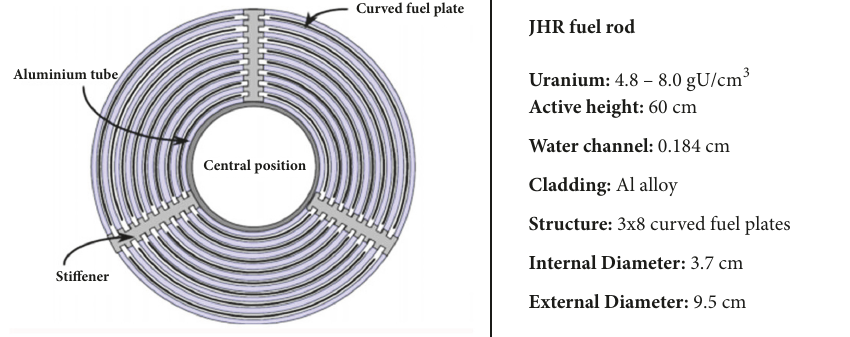
Figure 2: JHR fuel rod cross section.